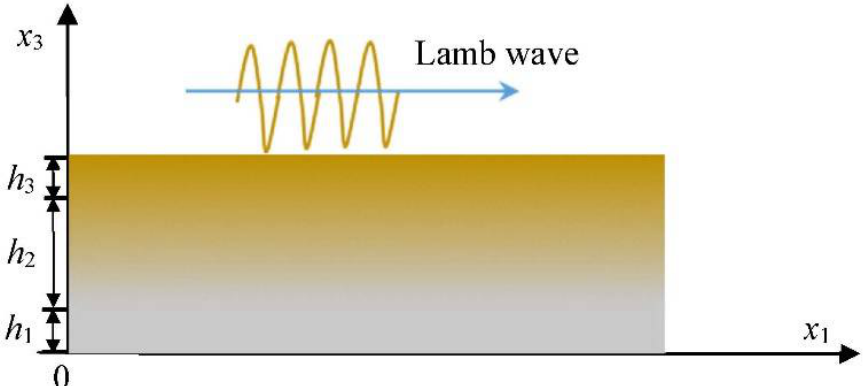
Figure 1. Schematic diagram of Lamb wave propagation and spatial coordinate system in a functionally graded material sandwich panel.